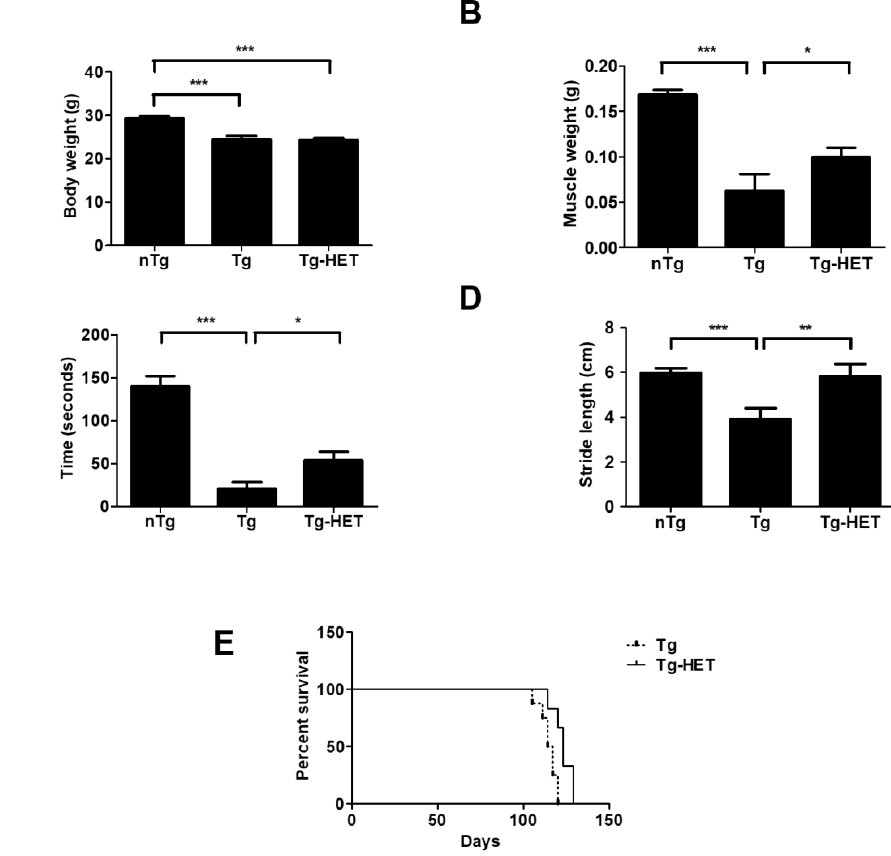
Figure 1. Hochu-ekki-to (HET) treatment ameliorates motor activity and prolongs the life span of a mouse model of amyotrophic lateral sclerosis (ALS). HET (1 mg / g) was orally administered once a day for 6 weeks from the age of 2 months. ( A ) Comparison of body weight between the nTg, Tg, and HET-treated Tg groups. ( B ) Comparison of gastrocnemius weight between the nTg, Tg, and HET-treated Tg groups. ( C ) Motor function was measured by the rota-rod test in all groups. ( D ) The representative average of stride length ( n = 7 / group) of each group, measured using the foot print test. ( E ) Survival rate was calculated by Kaplan-Meyer analysis in Tg and HET-treated Tg ( n = 8 / group). Data are shown as the mean ± SEM. * p < 0.05, ** p < 0.01, *** p < 0.001. nTg: non-transgenic